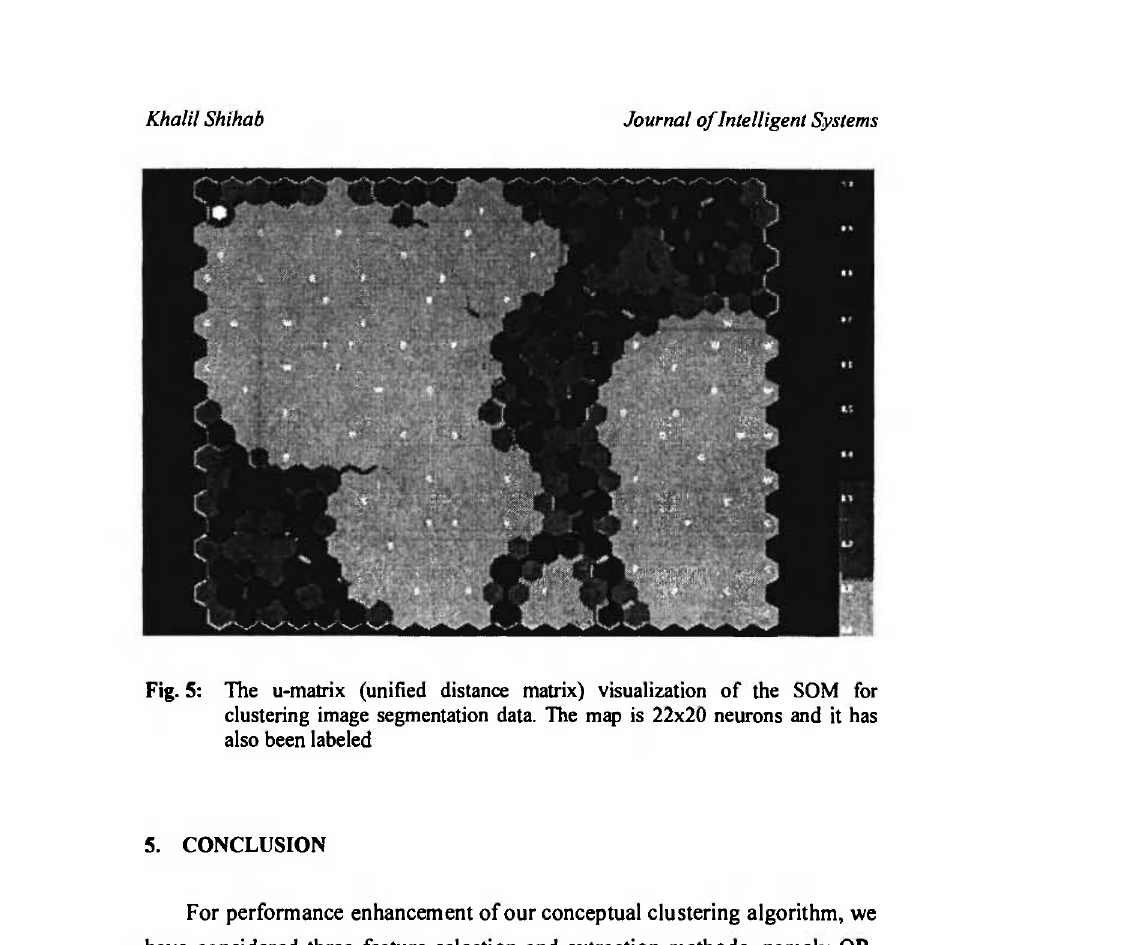
Fig. 5: The u-matrix (unified distance matrix) visualization of the SOM for clustering image segmentation data. The map is 22x20 neurons and it has also been